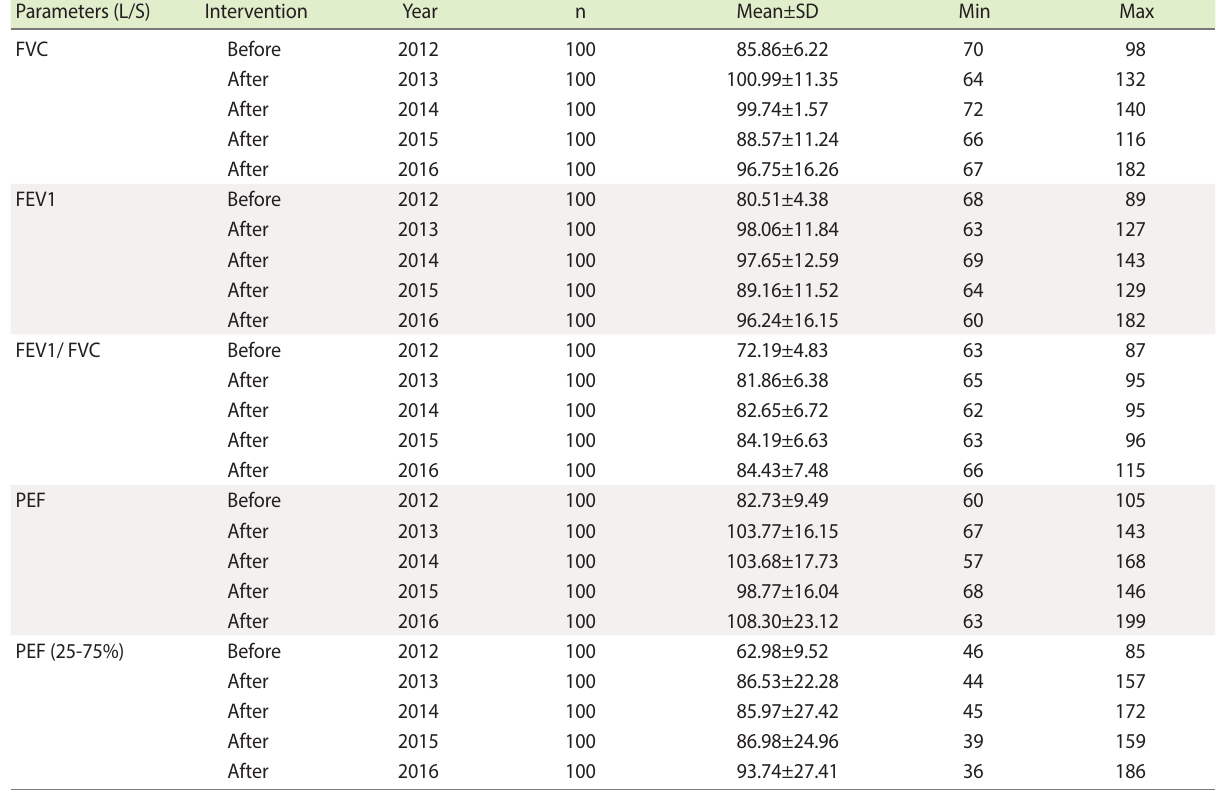
Table 2. Values of spirometric parameters by year, 2012-2016 Parameters (L/S)